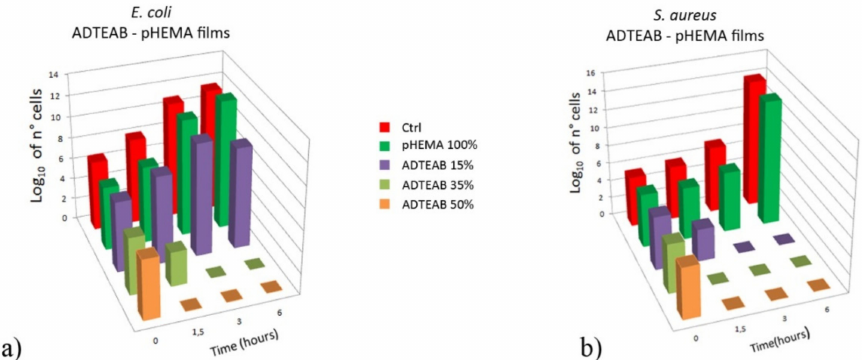
Figure 6. Comparison of viable cell number of E. coli TG1 ( a ) and S. aureus ( b ) as a function of time in the presence of control (no film, red histogram), blank reference (pHEMA, dark green histogram), 15% ADTEAB film (purple histogram), 35% ADTEAB film (light green histogram) and 50% ADTEAB film (orange histogram). Bacteria cells were grown in Luria-Bertani broth and the cell number was determined by surface spread plate technique, as described in the Materials and Methods